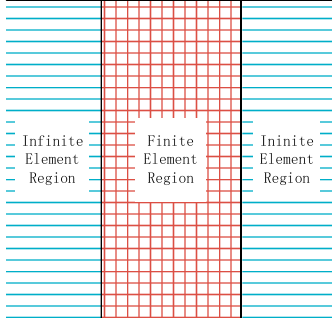
Figure 7. Strip model based on FE-IE coupling method.